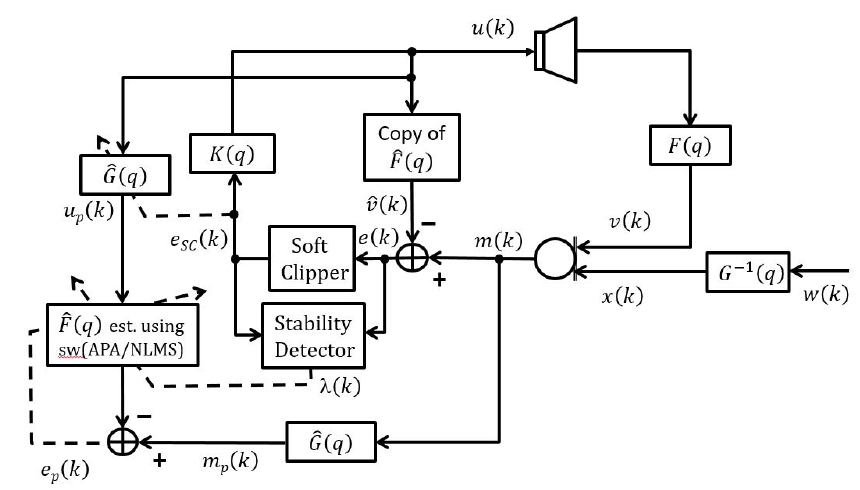
Figure 4. The model of the proposed method.